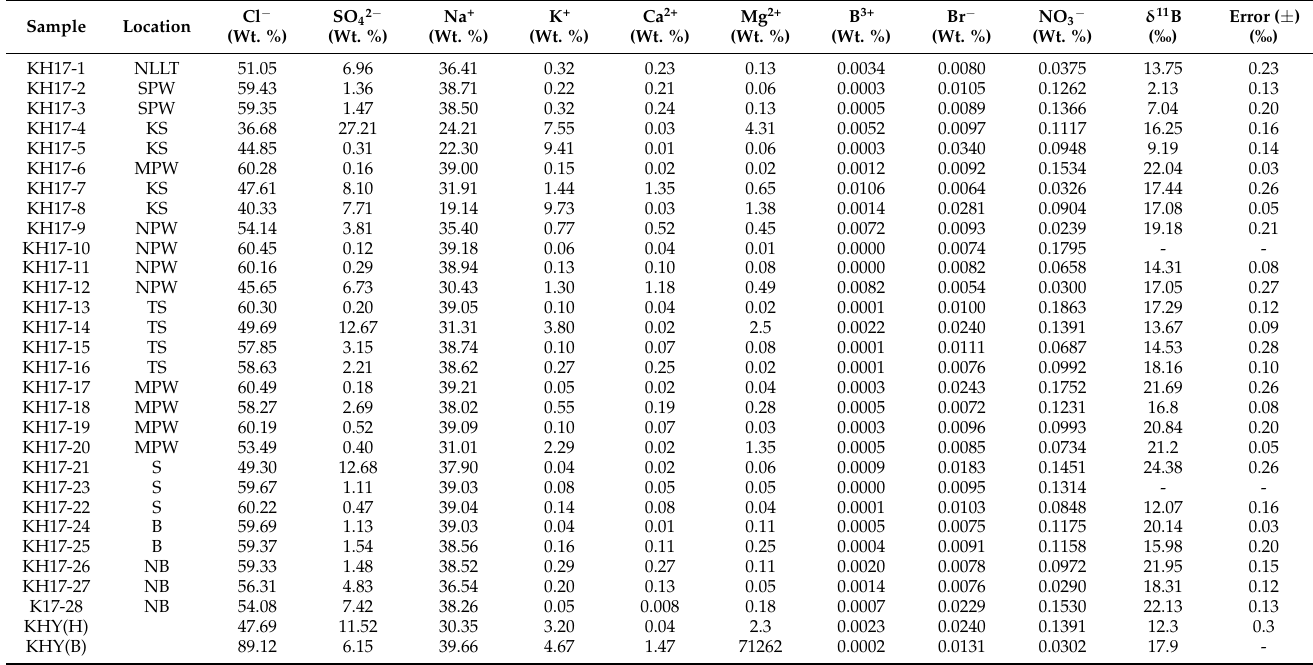
Table 1. δ 11 B values and ionic composition of halite with sample locations. SPW = South Pharwala, KS = Potash Seam, MPW = Middle Pharwala, NPW = North Pharwala, TS = Thin Seam, S = Sujowal, B = Buggy, NB = North Buggy (names are same as in Figure 3). KHY (H) and KHY (B) correspond to salt samples from two different pools, from where we collected the modern brines. Sample